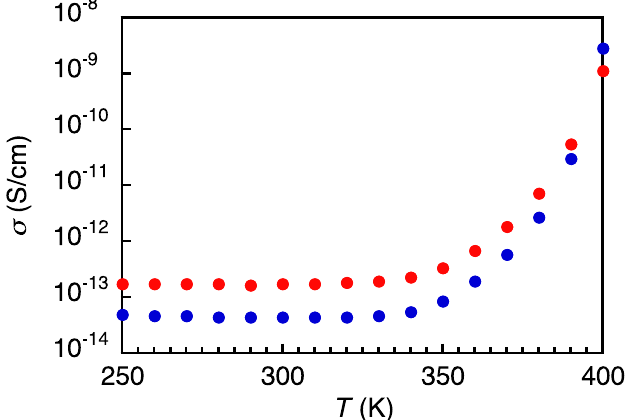
coordination polymers 1a (red) and 1b (blue).